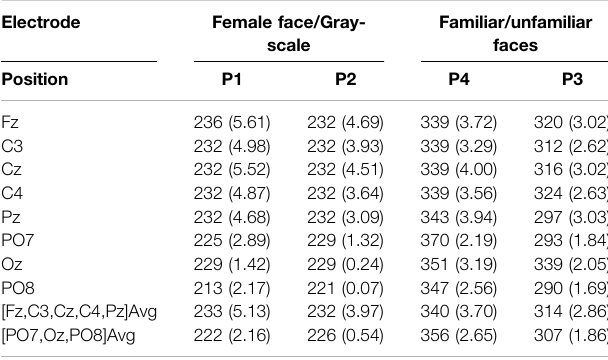
TABLE 3 | P300 latency ( ms ) and amplitude ( μ V ) taken from Figures 4 , 5 is listed for every paradigm (P1, P2, P3, and P4) and all electrode positions averaged forallsubjects.TheaverageofFz,C3,Cz,C4,Pz,andPO7,Oz,PO8iscalculated separately and listed. Electrode Female face/Gray-